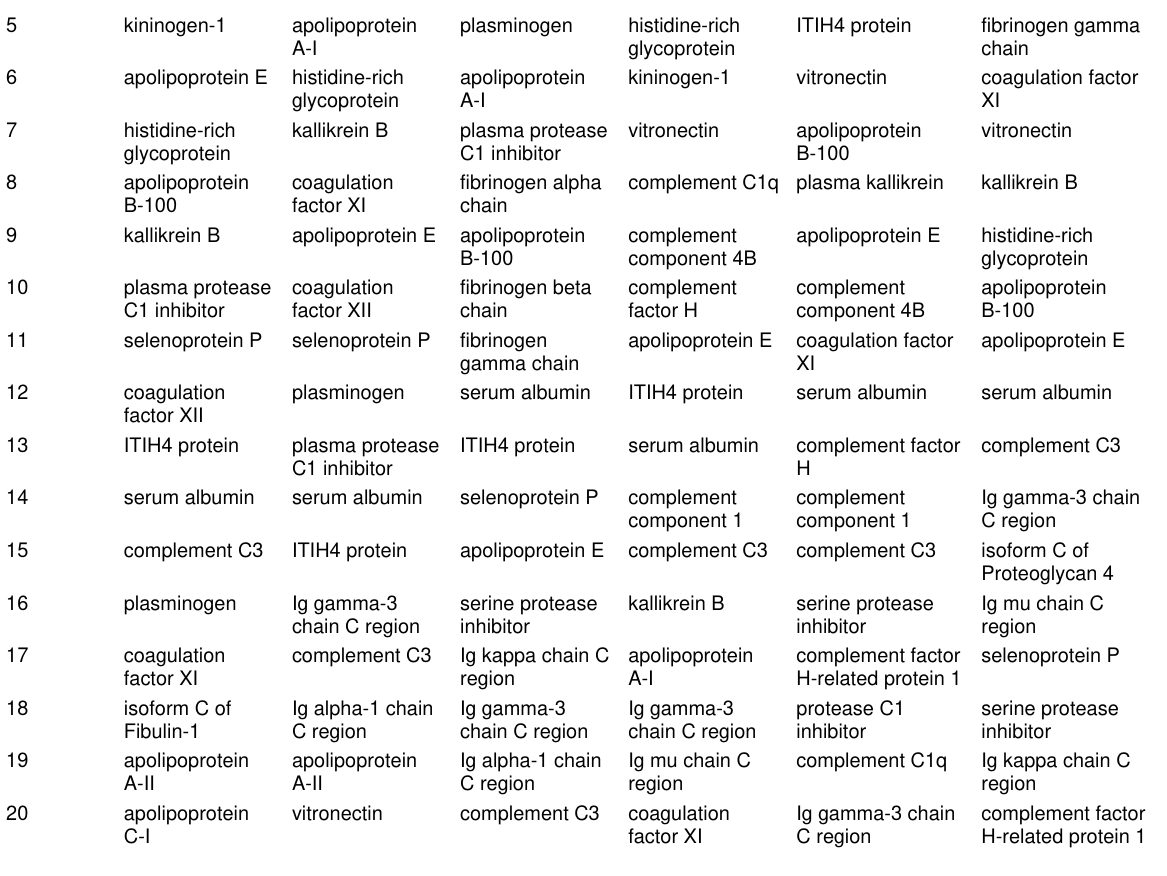
Table 4: Top 20 most abundant proteins in small silica (SNP-S) and carbon (CNP-S) nanoparticle hard corona samples at three different plasma con- centrations (10, 40, 80%) based on the LFQ intensity. (continued)